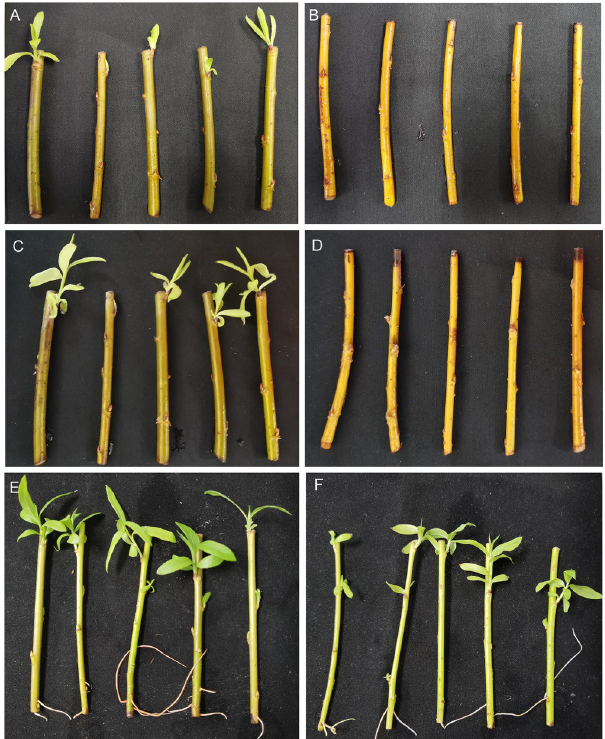
Fig 1. ‘9901’material possessed stronger salt resistance than ‘Yanjiang’. Stems of ‘9901’ and ‘Yanjiang’ varieties were cultured via hydroponics in Hoagland medium supplemented with or without 100 mM NaCl. The time for shoot development and number of shoots were assessed every day, and the phenotype was recorded on day 9 and 15. (A), ‘9901’, 9 d under salt treatment; (B), ‘Yanjiang’, 9 d under salt treatment; (C), ‘9901’,15 d under salt treatment; (D),